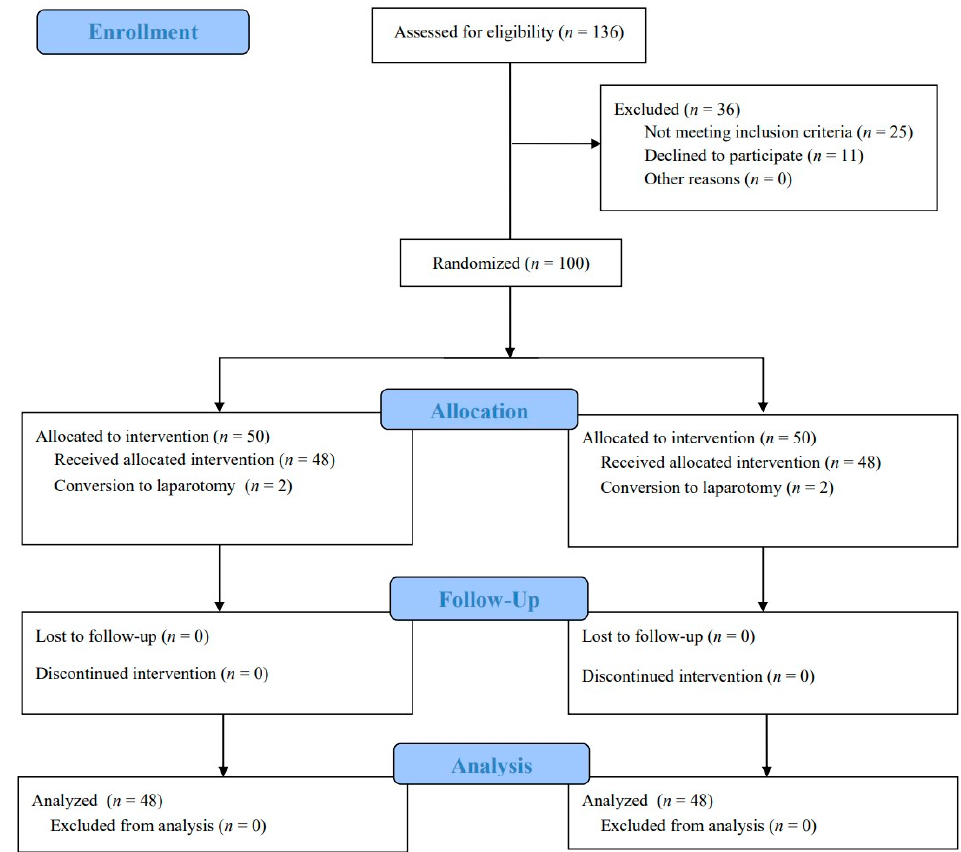
Figure 1. CONSORT 2010 flow diagram.